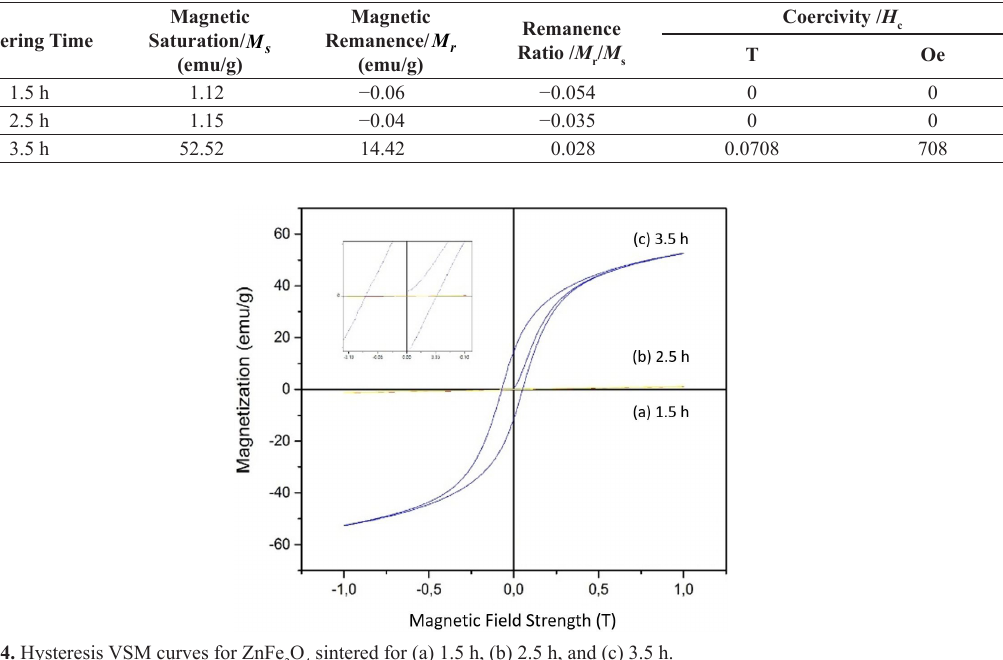
Figure 4. Hysteresis VSM curves for ZnFe